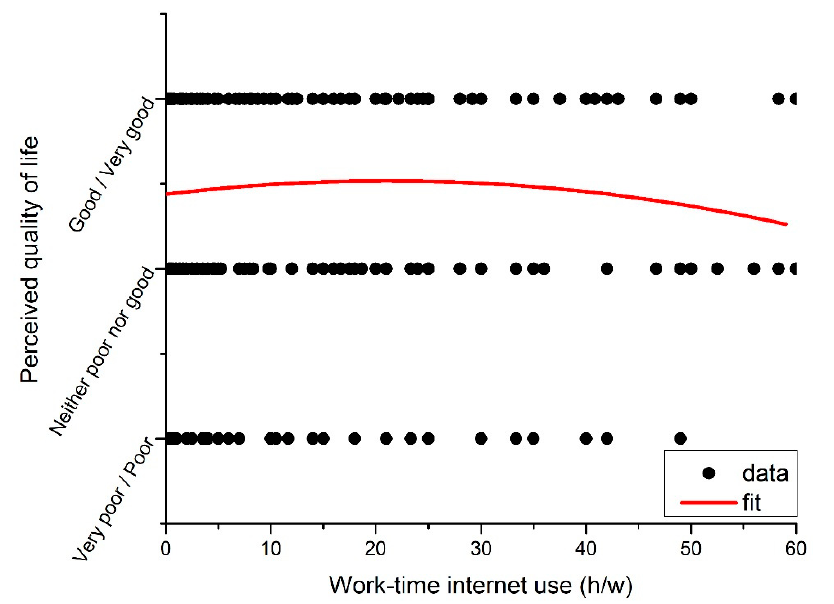
Figure 2. The scatterplot of perceived quality of life versus work-time internet use.